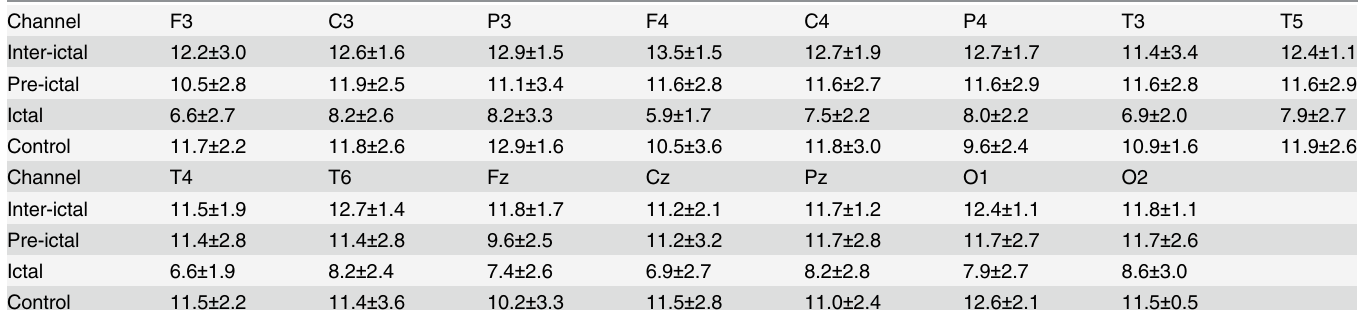
Table 3. The complexity index for age-matched controls and inter-ictal, pre-ictal and ictal states of absence seizures showing no difference in age- matched controls, inter-ictal, and pre-ictal state. However, there was significant decrease of CI values in ictal state compared with pre-ictal state (P <